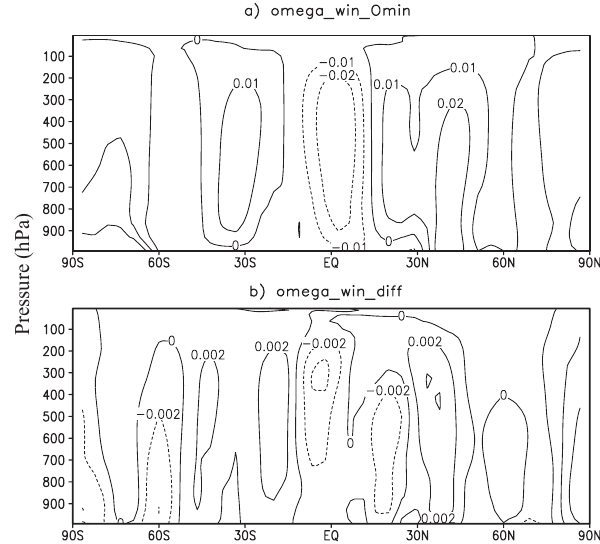
Fig. 9. The simulated TL composite of vertical velocity (Pas − 1 ) in boreal winter averaged 80–150 ◦ E (a) and the difference between TH and TL (b)